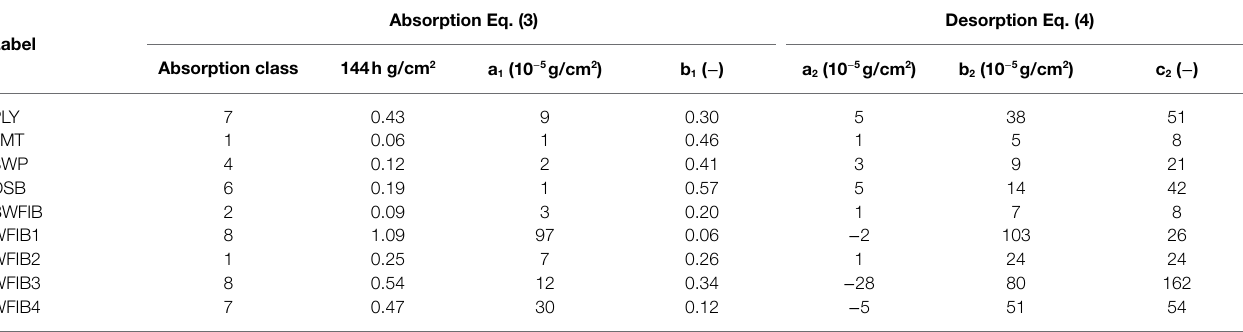
TABLE 5 | Overview of the residual moisture ( ω r ; %) after 48, 96 and 144 h of desorption.